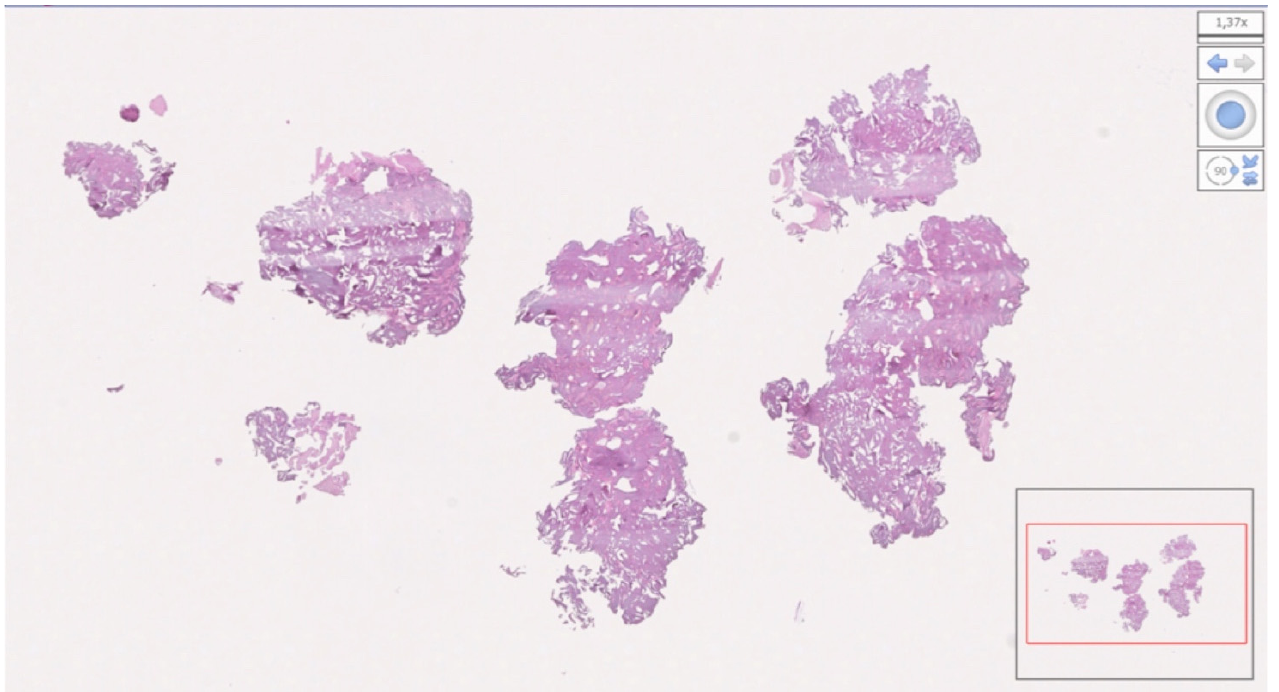
Figure 13. Bone sample taken at the upper right second premolar. The patient (number 10) received L-PRF mixed with decellularized bovine compact bone from bovine femur. The bone was 48.22%; soft tissue was 48.92%; residual graft was 2.86%.